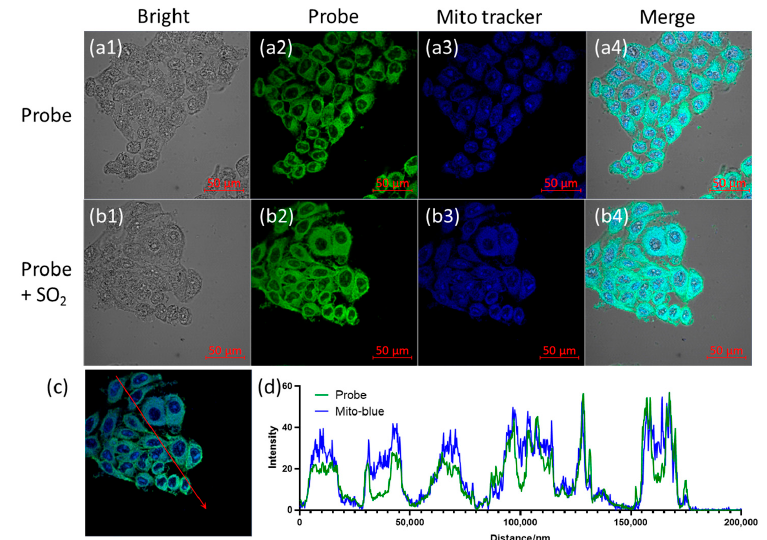
Figure 5. Confocal images of colocalization between the probe and newly synthesized blue mito- chondrial tracker. ( a1 – a4 ) Cells were incubated with B2P and blue tracker (both 10 μ M) for 20 min; ( b1 – b4 ) cells were incubated with B2P–HSO 3 and blue tracker for 20 min. From left to right: bright field; green channel (for probe): λ em = 480–520 nm; blue channel (for tracker): λ em = 410–450 nm ( λ ex = 405 nm); merge. Scale bar, 50 μ m. Furthermore, ( d ) shows the intensity of the green and blue fluorescence signal intensity on the red line in ( c ).